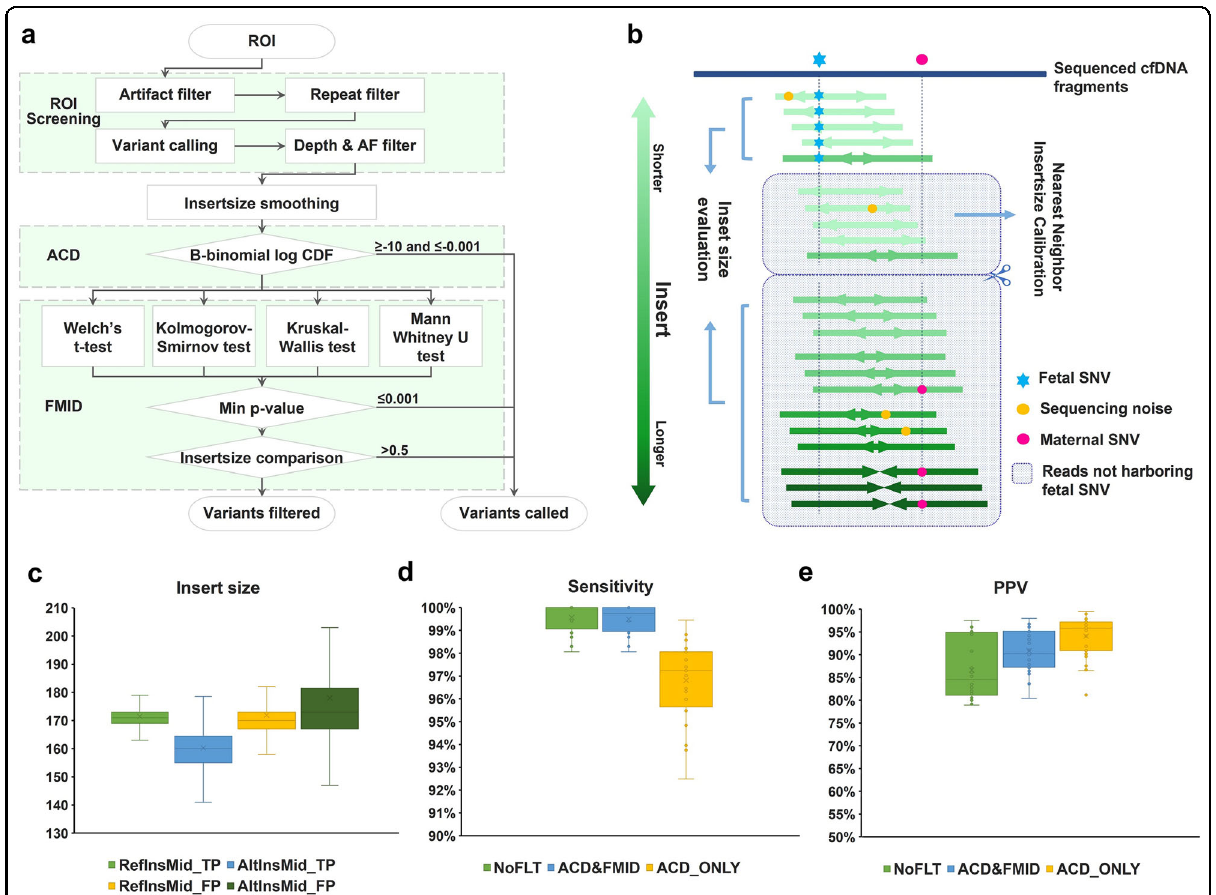
Fig. 5 The use of cfDNA characteristics for the detection of fetal monogenic variants. a The identi fi cation of fetal monogenic variants includes ROI analysis, ACD fi ltering, and FMID fi ltering. b Fetal-Maternal Nearest Neighbor Insert-size Calibration was fi rst used to exclude those reads harboring wild-type alleles which possess the closest cfDNA fragment length to the reads harboring the variant alleles of a potential fetal origin. The remaining fragments with the wild-type allele were compared with those with the variant alleles for their lengths to identify potential fetal SNVs. c Different insert-size distribution for wild-type (ref) and variant (alt) allele supporting reads on 28 samples tested. For all variants detected, median insert-size of ref (Re fi nsMid) and alt (AltinsMid) allele supporting reads were box plotted with upper whisker (Q3 + 1.5 × IQR), Q3, Q2, average, Q1, and lower whisker (Q1 – 1.5 × IQR) to demonstrate the differences between the TP or FP variants. Insert-size was ~10 bp shorter ( P < 1.0 × 10 − 15 , two- tailed unequal-variance t -test) in alt allele group compared to ref allele group on TP variants consistent with a fetal origin and no such difference was seen in FP variants. d , e Sensitivity ( d ) and PPV ( e ) comparison for different fi ltering methods using 28 validation samples. By applying both the ACD and FMID variant fi lters, the test sensitivity was essentially unchanged at 99.5% while the PPV was signi fi cantly improved ( P < 0.01). When only the ACD fi lter was used, the test sensitivity was reduced to 96.8% ( P < 1.0 × 10 − 8 ). Upper whisker (Q3 + 1.5 × IQR), Q3, Q2, average, Q1, lower whisker (Q1 – 1.5 × IQR), and all non-outlier data points between lower and upper whiskers were demonstrated on the box plot. The ACD and FMID fi lters were used to fi lter in variants of a likely fetal origin. Ref reference, Alt alternative, TP true positive, FP false positive, Q1 lower quartile, Q2 median quartile, Q3 upper quartile, IQR inter-quartile range = Q3 – Q1; ROI regions of interest, ACD allele count distribution, FMID fetal-maternal insert-size distribution, PPV positive predictive value, FF fetal fraction, AF allelic fraction Min P -value, minimum of the four P -values to examine whether alternative allele fragments are signi fi cantly different from the reference allele fragments in length. CDF, the absolute value of the log cumulative distribution function value; NoFLT no variant fi lter